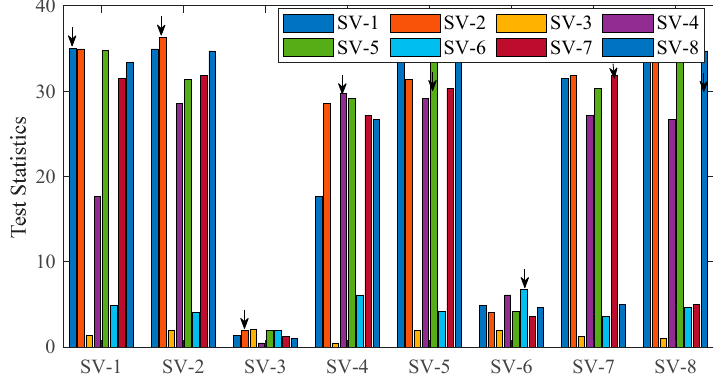
Figure 10. Statistics for GNSS fault exclusion when fault occurs in SV-3.